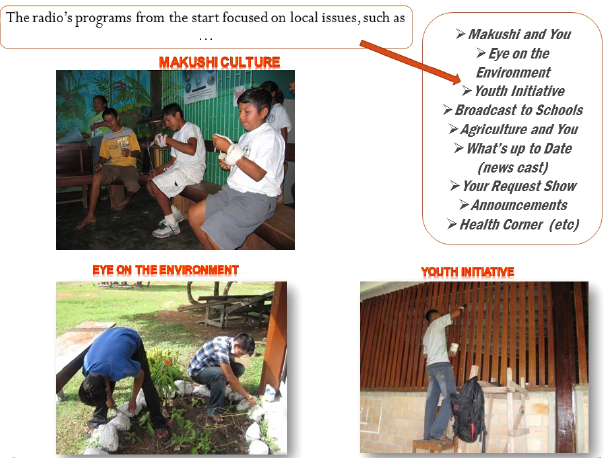
Fig. 4 . An extract of the adaptability best practice photostory showing the different radio programs aired on the community radio